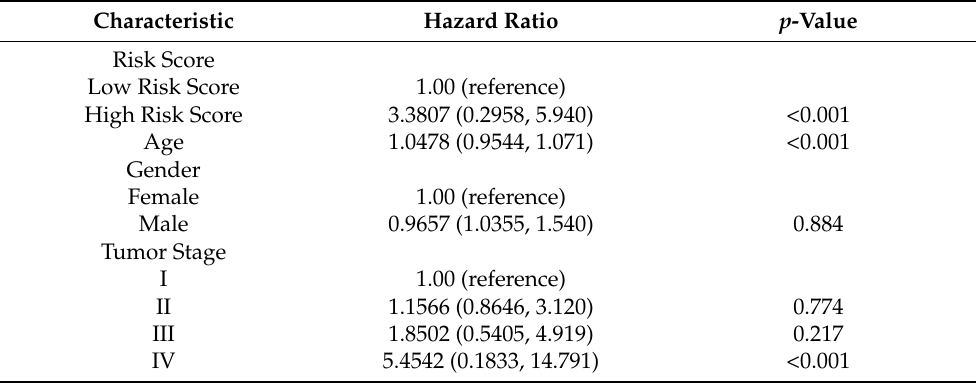
Table 2. Multivariate logistic regression for predicting